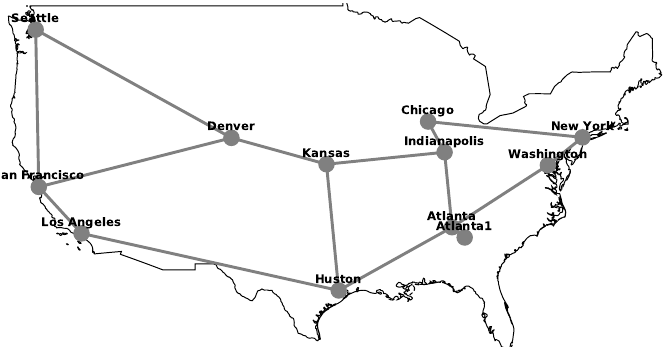
Figure 4. Schematic diagram of American national transmission optical backbone network.